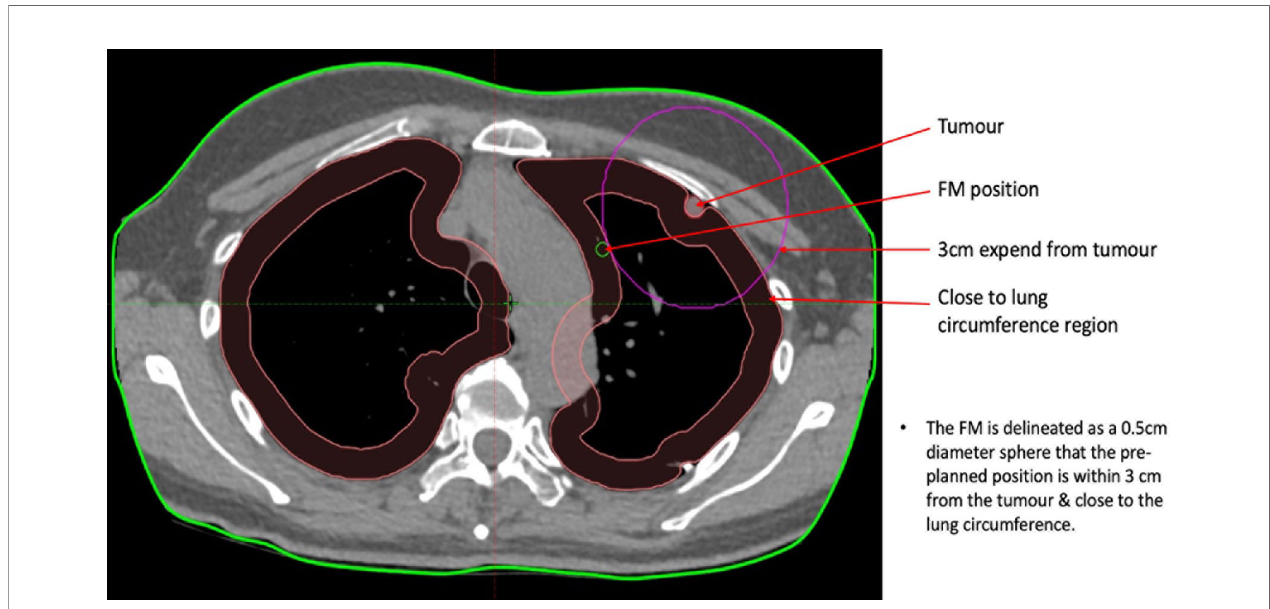
FIGURE 2 | Illustration of the guidelines for the pre-planned FM